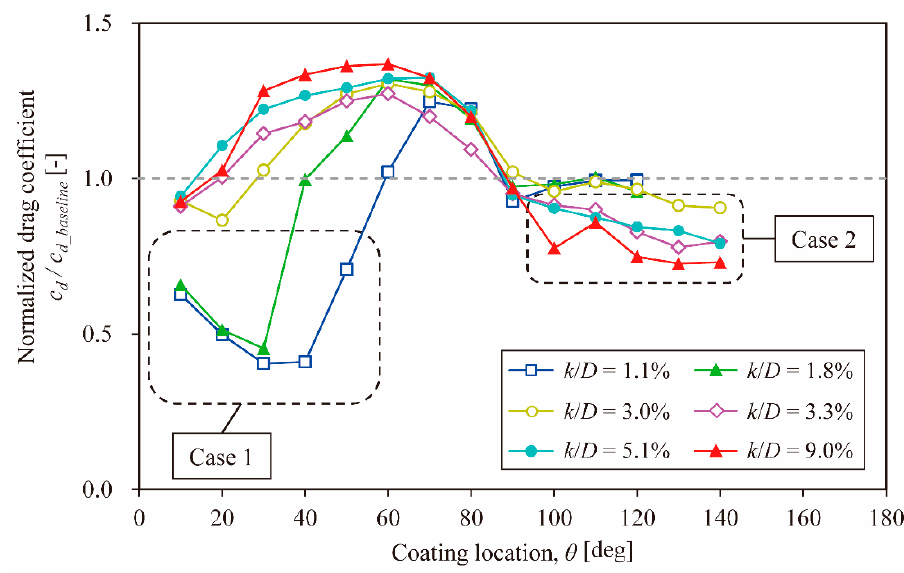
Figure 4. Comparison of drag varying with relative microfiber length and coating location.